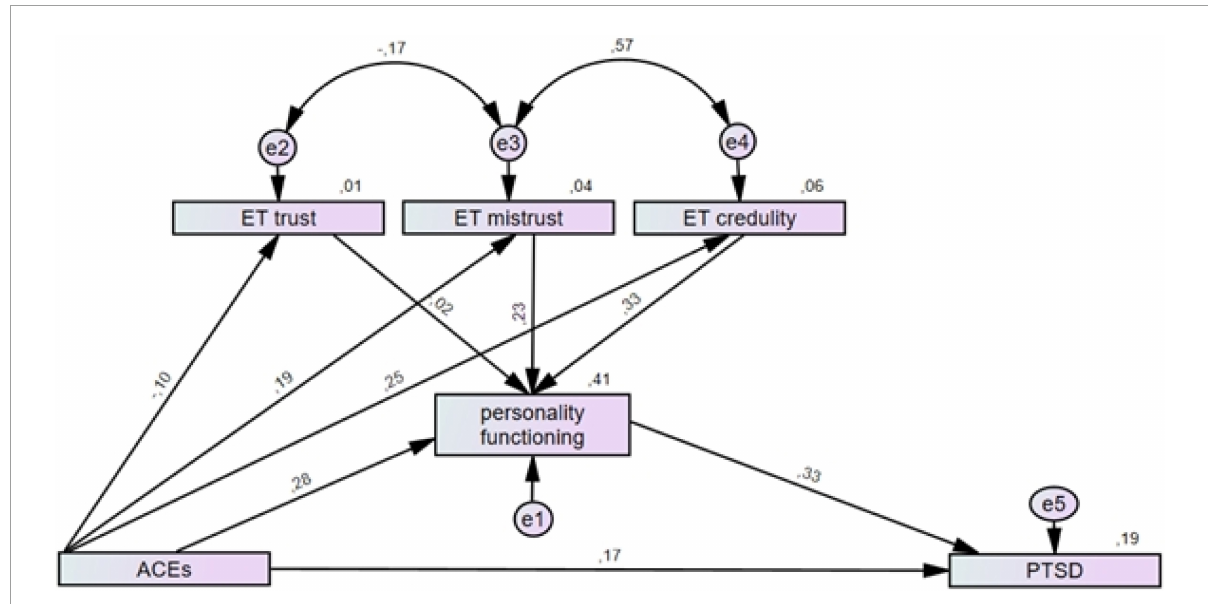
FIGURE2 Structural equation models for the mediation effect of personality functioning and epistemic trust on the relationship of ACEs with PTSD symptoms. Personality functioning was added as a mediator for the association between ACEs and PTSD and the three epistemic trust subscales as predictors of personality functioning. Rectangles represent variables (ACEs, Adverse Childhood Experiences measured by the ACE; personality functioning measured by the OPD-SQS; ET, epistemic trust measured by the ETMCQ; PTSD, posttraumatic stress disorder symptoms measured by the ITQ) and circles represent error terms (e). Numbers next to arrows in the model represent standardized estimates, numbers next to factors represent the R2, i.e. the explained variance.